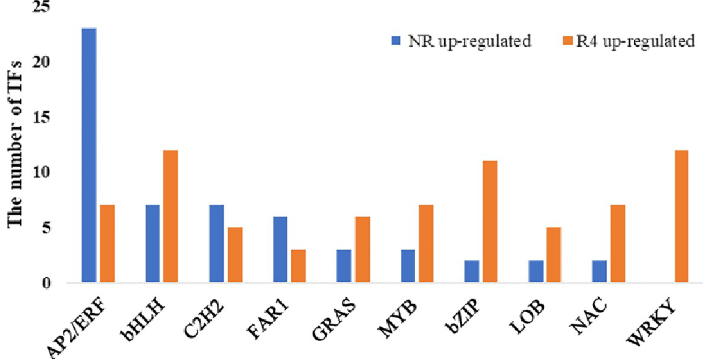
Fig 4. Bar plot of the number of transcription factors differentially expressed in R4 and